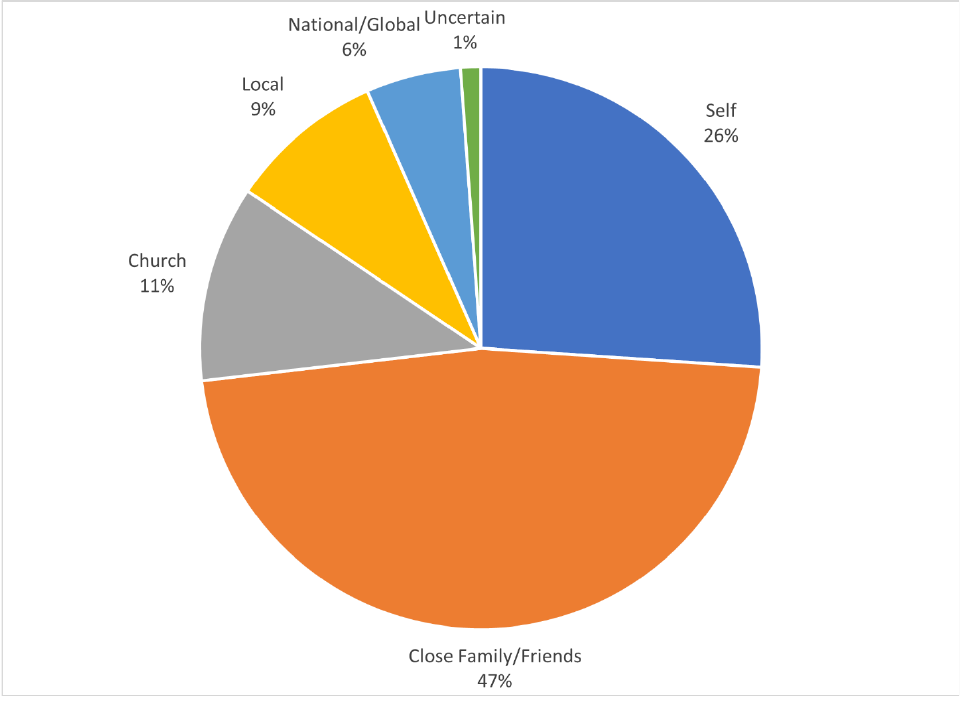
Figure 4. Focus of Sharing.